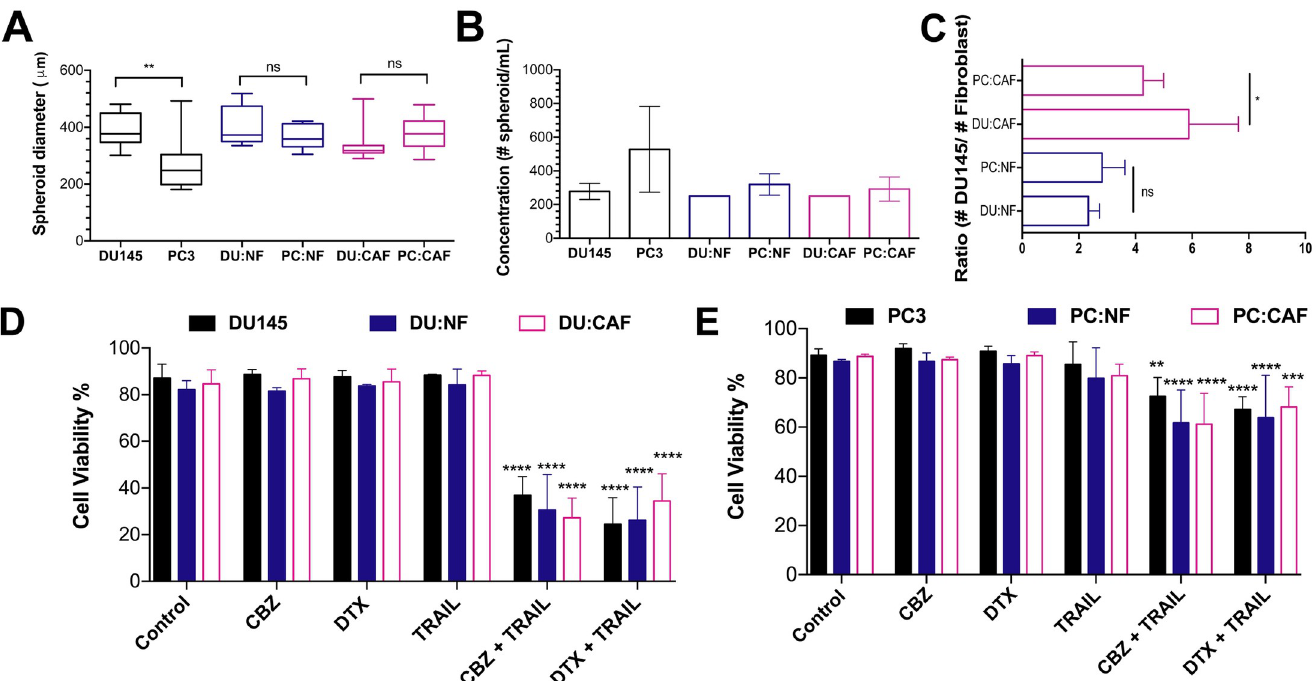
Fig 8. Cocultured spheroids show similar drug resistance to taxane plus TRAIL therapy. A . Diameters of mono- and cocultured DU145 and PC3 spheroids with NFs and CAFs. B . Concentration of spheroids/mL of mono- and cocultured DU145 and PC3 spheroids with NFs and CAFs. C . Ratio of NFs and CAFs in co-cultured DU145 and PC3 spheroids. D . Ratio of PC3 cells to fibroblasts in cocultured spheroids. The values represent the mean ± SD (n = 3). � p < 0.05, p �� < 0.01, ���� p < 0.0001, significantly different from control.